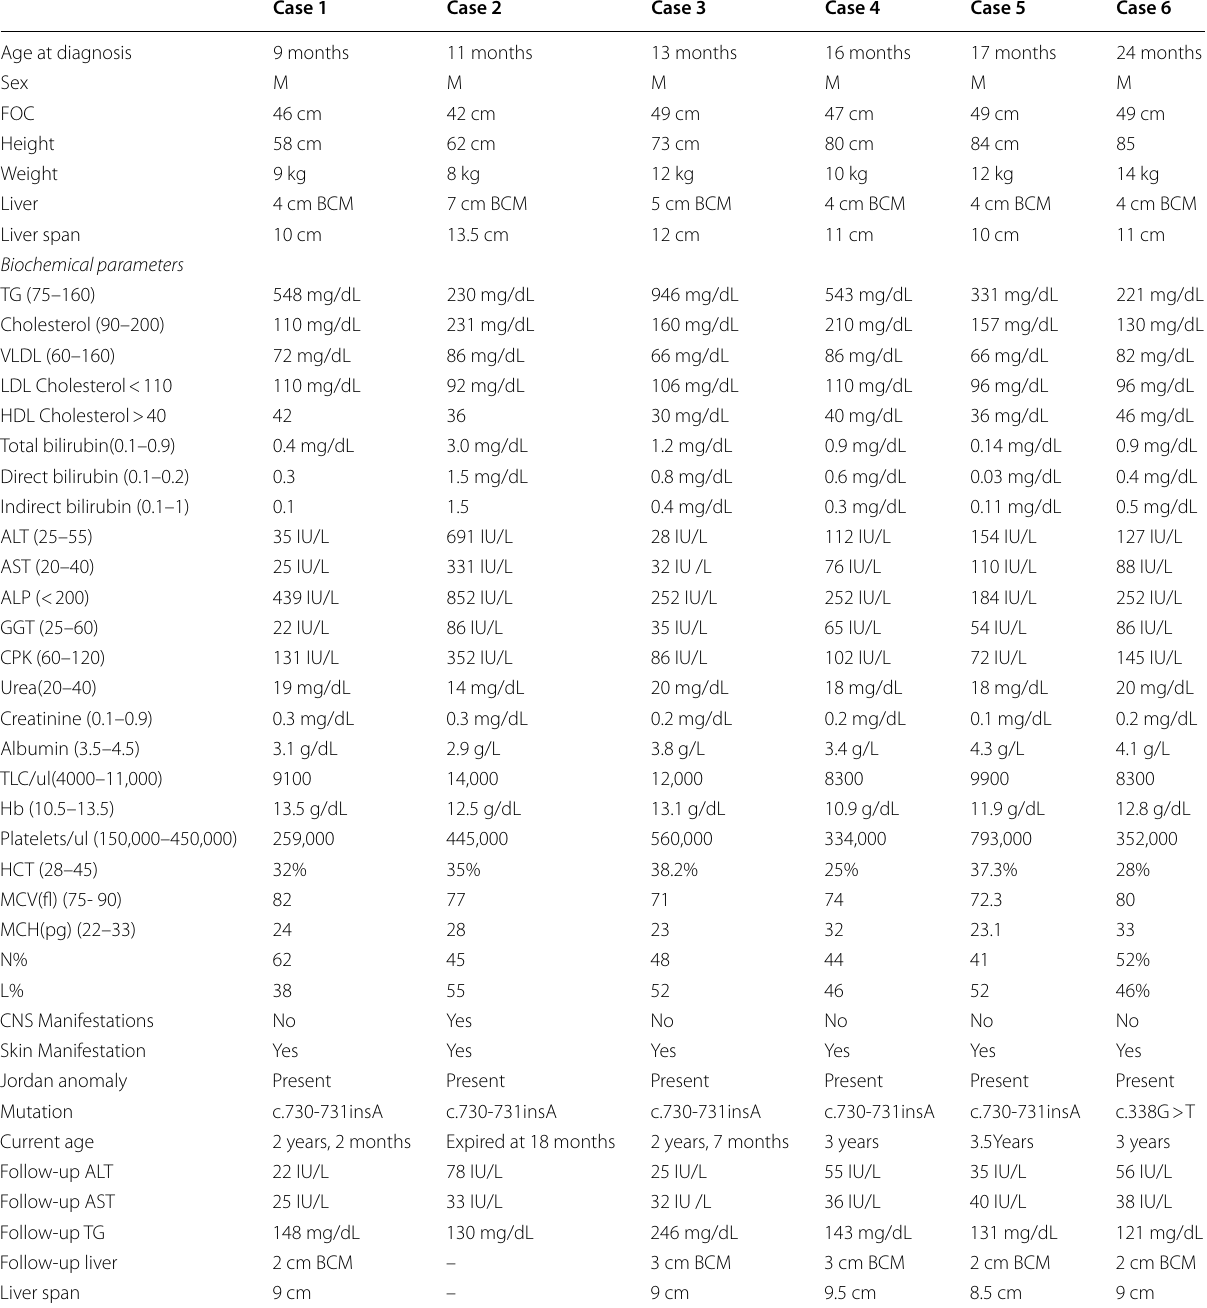
Table 1 Biochemical parameters and ABHD5